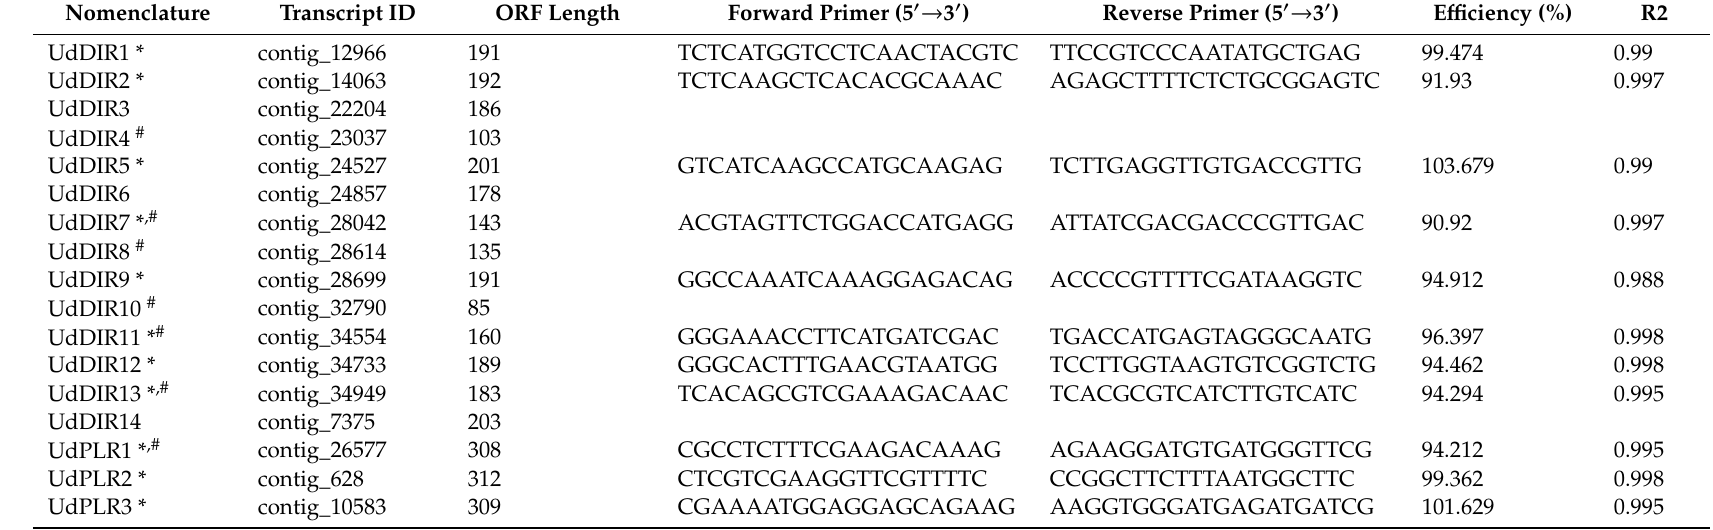
Table 1. Details of the identified dirigent proteins ( DIR s) and pinoresinol-lariciresinol reductase ( PLR s) in U. dioica with proposed nomenclature, transcript ID